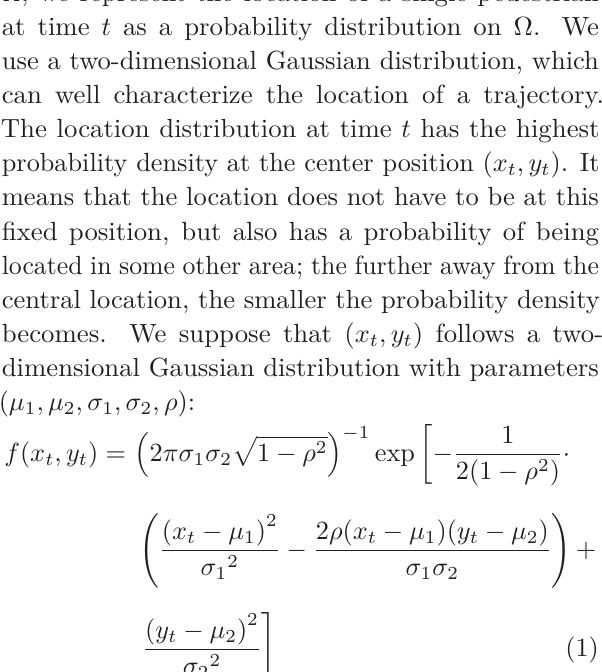
Fig. 2 A trajectory distribution describes the location of a pedestrian as a probability distribution. (a) Distribution for a certain trajectory. (b) Areas of influence for different values of σ of the probability